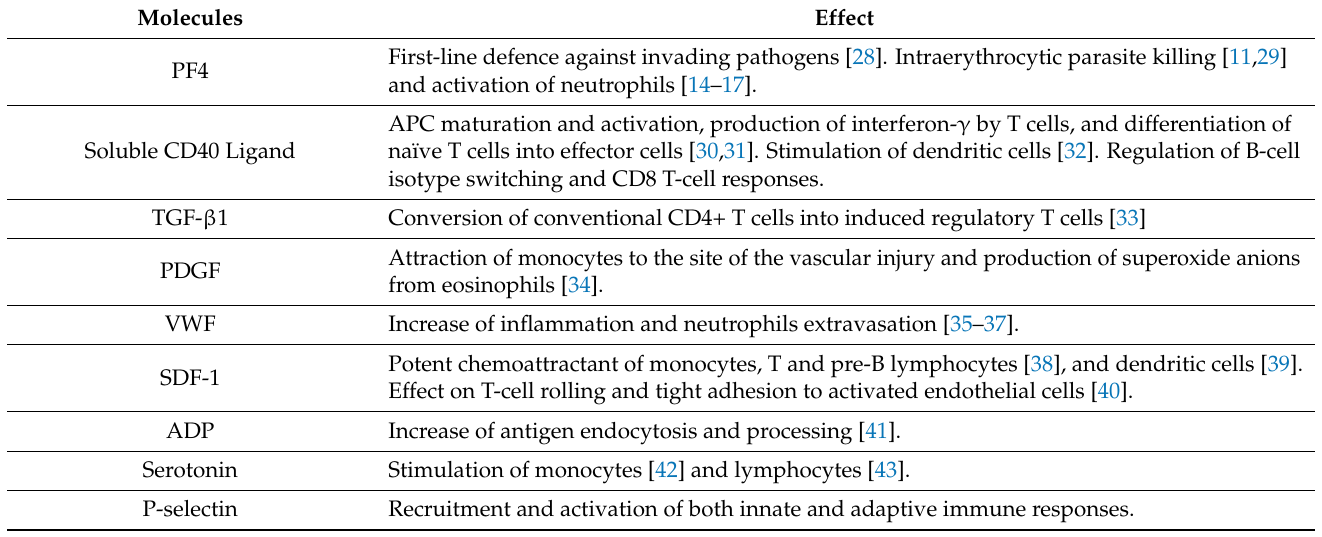
Table 2. Molecules released from platelets during